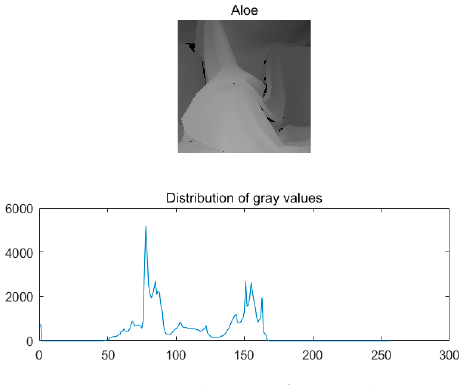
Figure 1. Distribution of grey values.